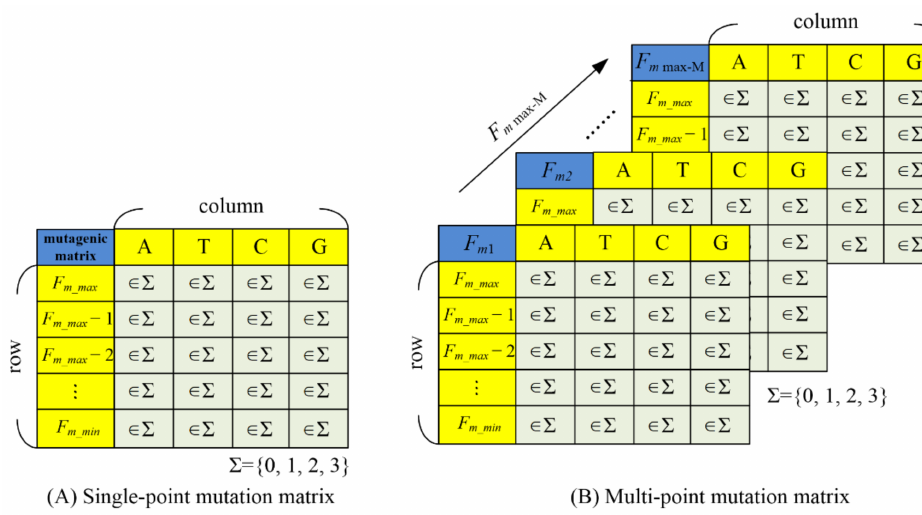
Figure 2. Single- and multi-point mutagenic